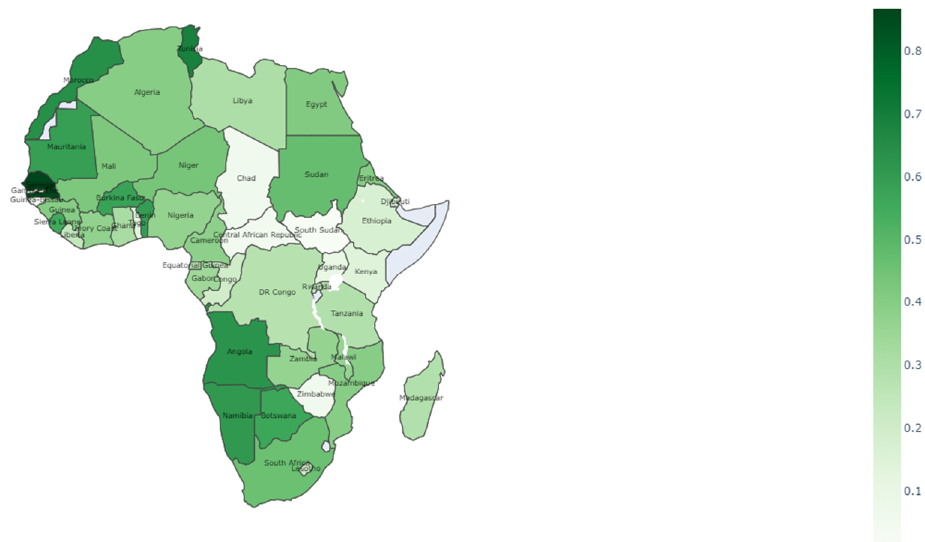
Figure 5. Cumulative results for values of synthetic sustainable growth indices for the studied African countries in 2010–2018—a model to support standardization by dividing all terms in a series by the maximum values in the series ©. Source: own work.